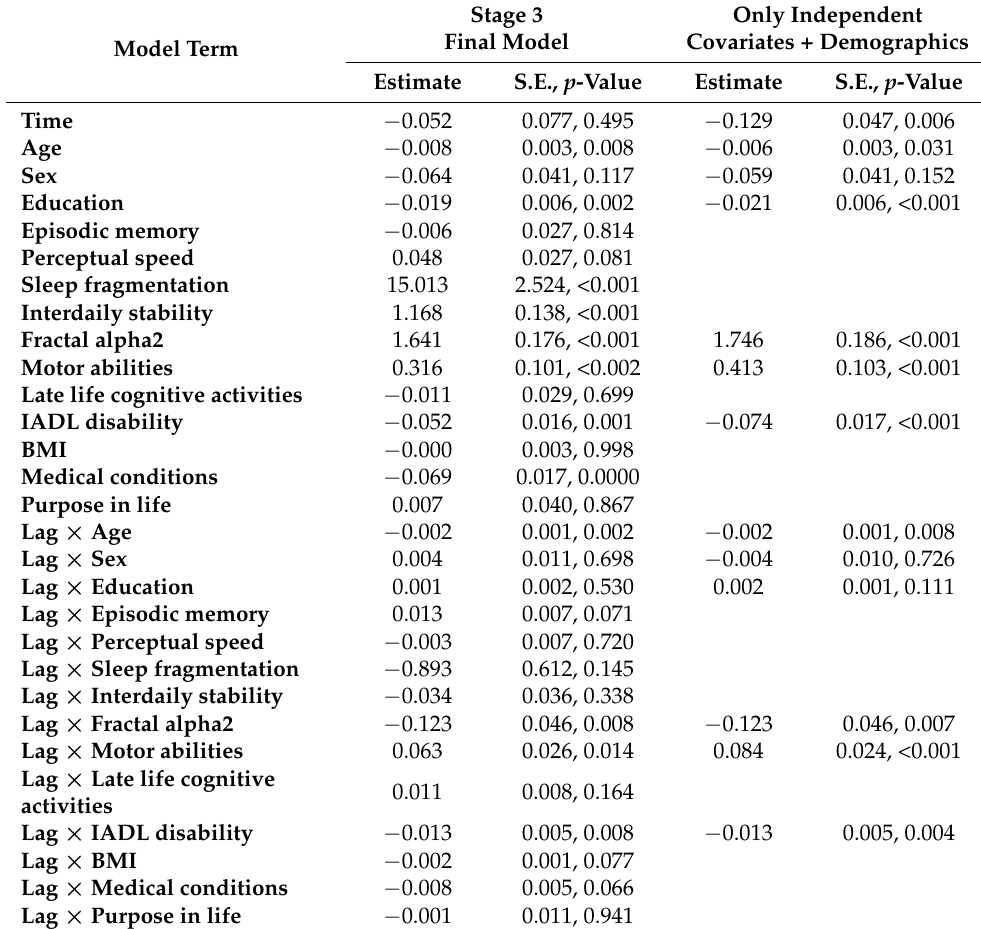
Table 3. Identifying Covariates Independently Associated with Declining Total Daily Physical Activity.